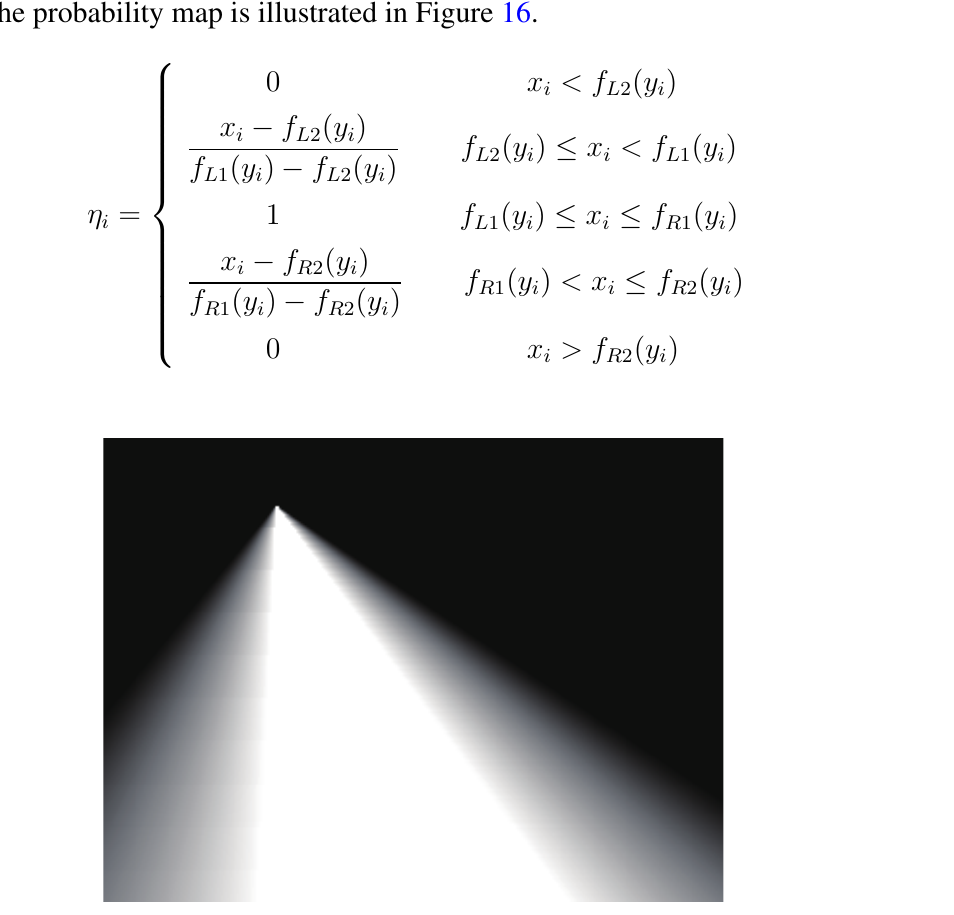
Figure 16. Probability map obtained according to the position of the road vanishing point (the brighter pixel stands for the higher